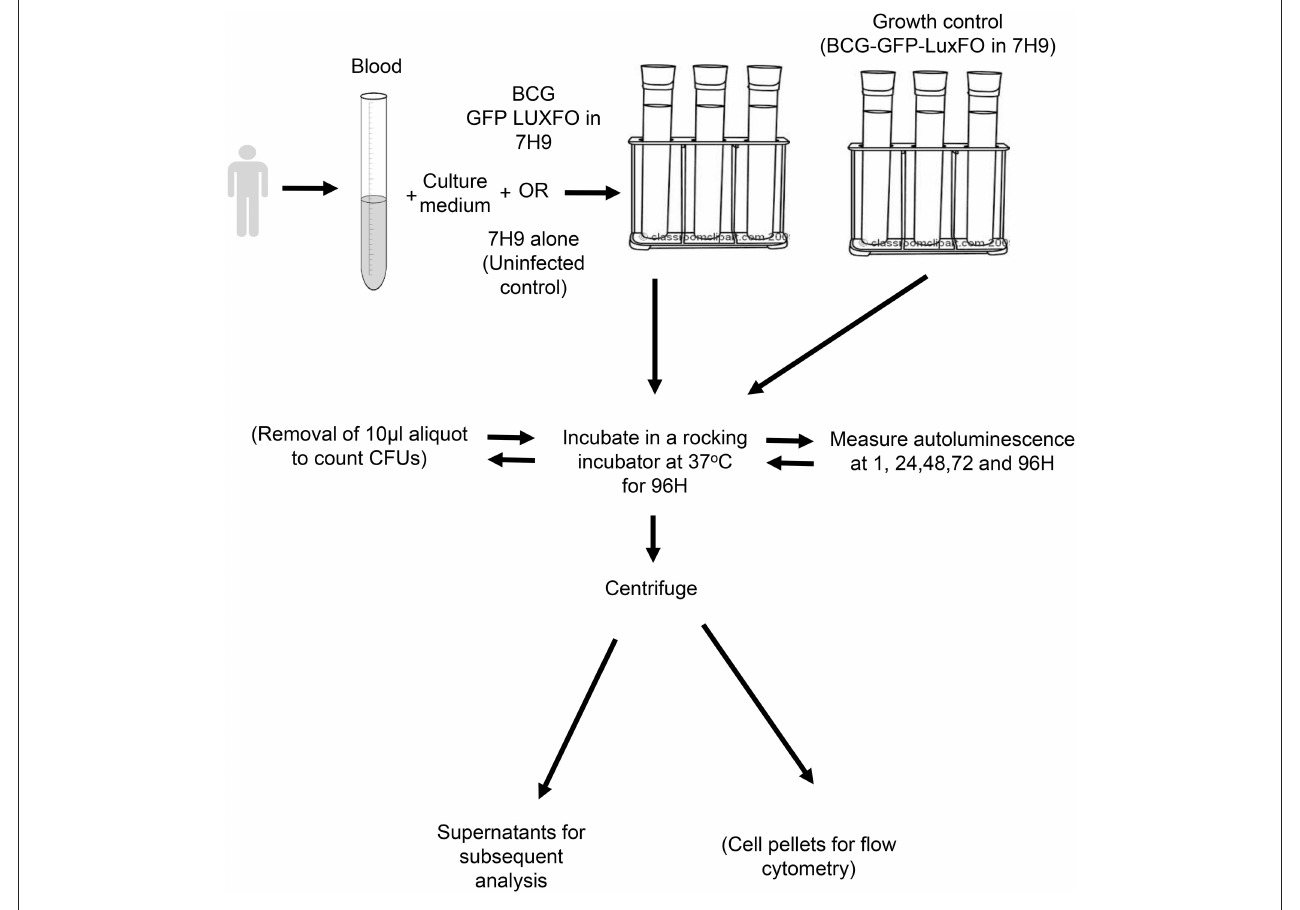
FIGURE 1 | Schematic of BCG-GFP-LuxFO whole blood assay method.